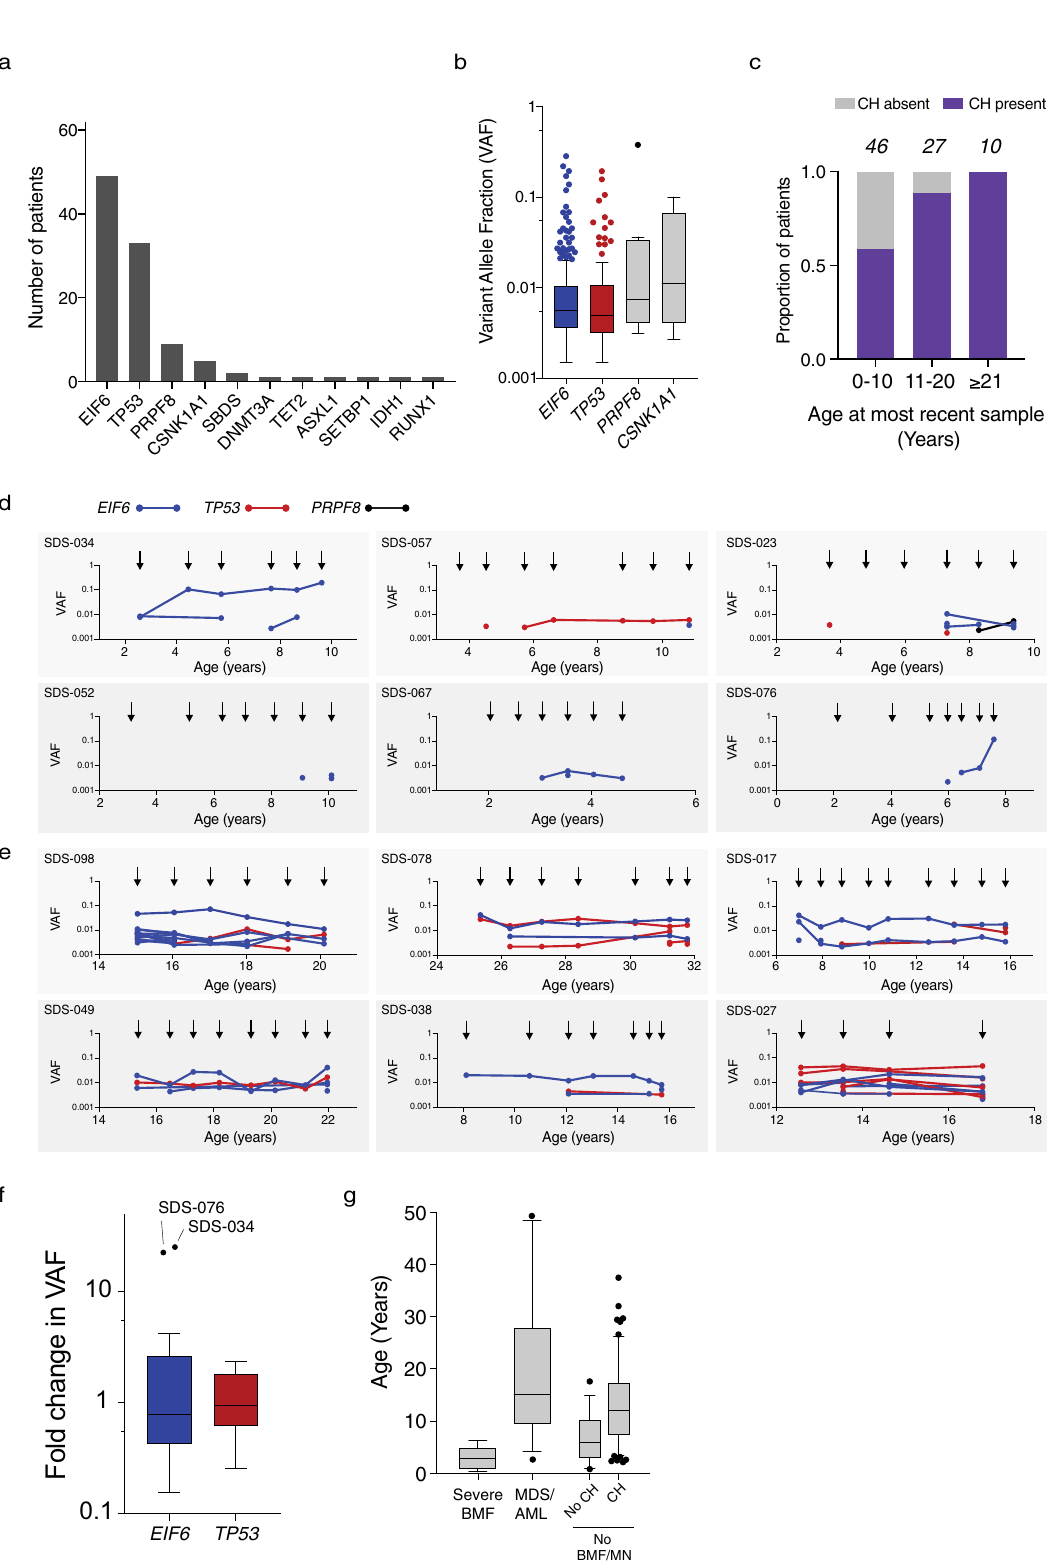
found that SDS patients can develop multiple, independent TP53 - mutated clones and that serial monitoring by bulk sequencing fails to distinguish clinically signi fi cant subclonal changes in TP53 allelic state. These fi ndings suggest that integration of single cell DNA sequencing into surveillance strategies might identify patients with high risk clones prior to clinical transformation. In NATURE COMMUNICATIONS| (2021) 12:1334